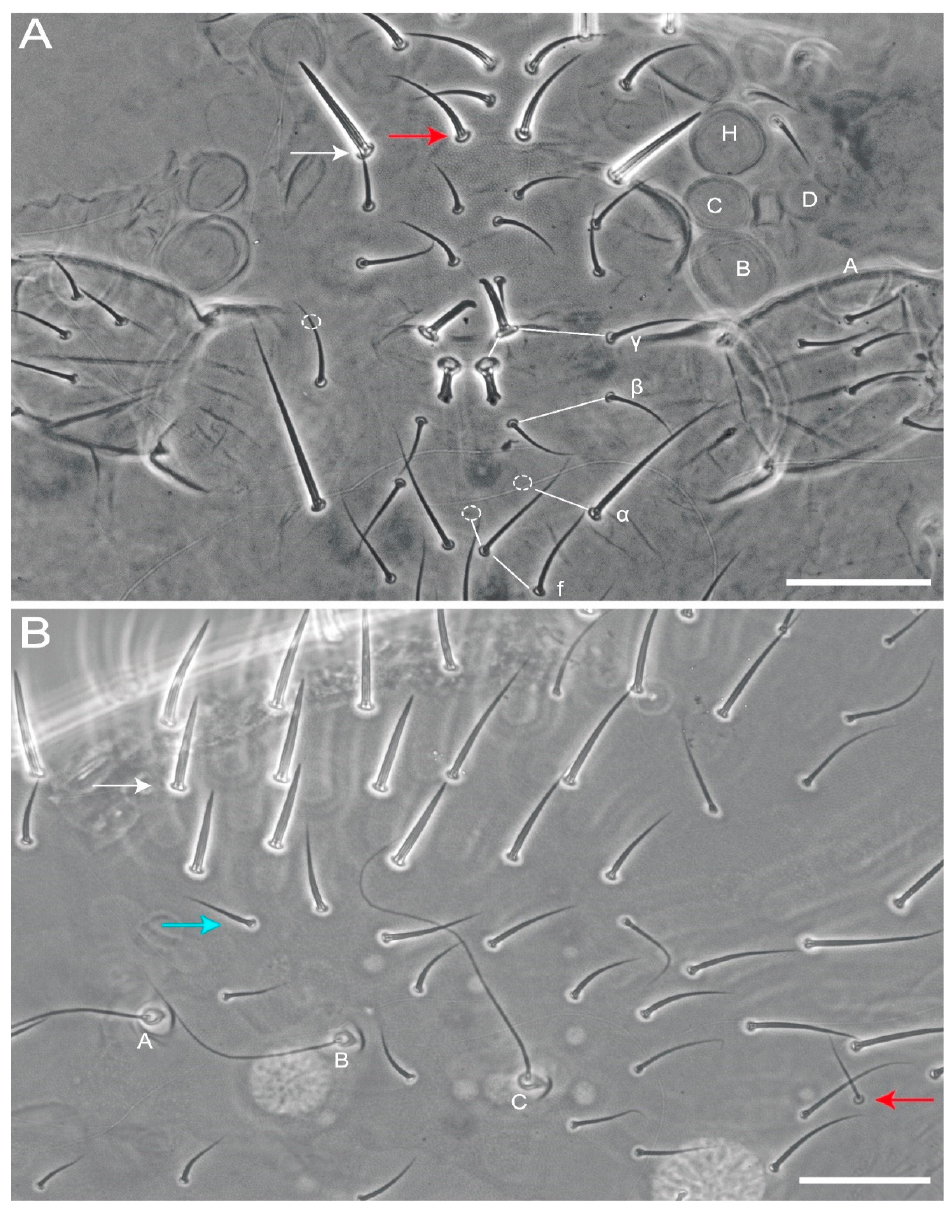
Figure 5. Arlesminthurus caatinguensis sp. nov., male structures. ( A ) Part of the head chaetotaxy (frontal, interocular and occipital regions); the white arrow shows a spine and the red arrow a spine ‐ like chaeta; A–D and H represent the eyes; dashed circles indicate chaetae present or absent; white lines are clypeal (f) and frontal lines ( α , β and γ ). ( B ) Part of the large abdomen (lateral view); A–C represent the bothriotricha; the white arrow shows a spine; the blue arrow shows a spine ‐ like chaeta; and the red arrow indicates an extra bothriotrichum ‐ like sens on the inferior side. Scale bars: 0.04 mm.